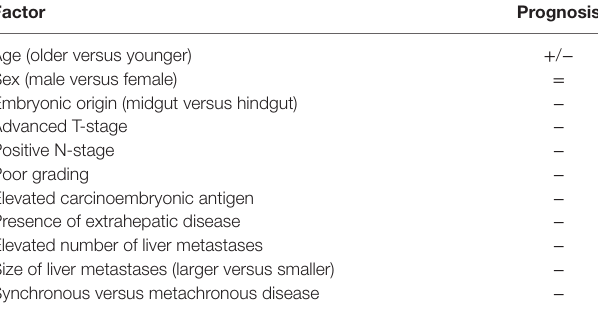
TabLe 1 | Traditional prognostic factors of colorectal liver metastases patients. Factor